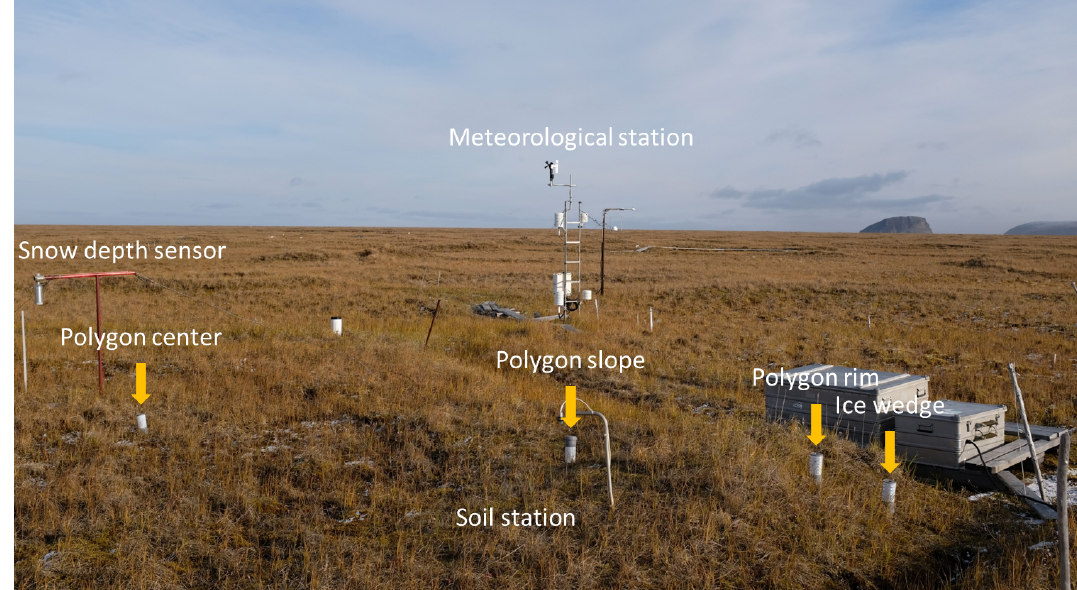
Figure B9. Samoylov research site in September 2017, showing locations of meteorological station and soil station (consisting of sensors installed along 1-D profiles within polygon centre, rim, slope, and ice wedge). White/grey tubes have been placed on the surface to indicate the locations of the subsurface sensors and their respective microtopographic locations (polygon centre, rim, slope, and ice wedge).